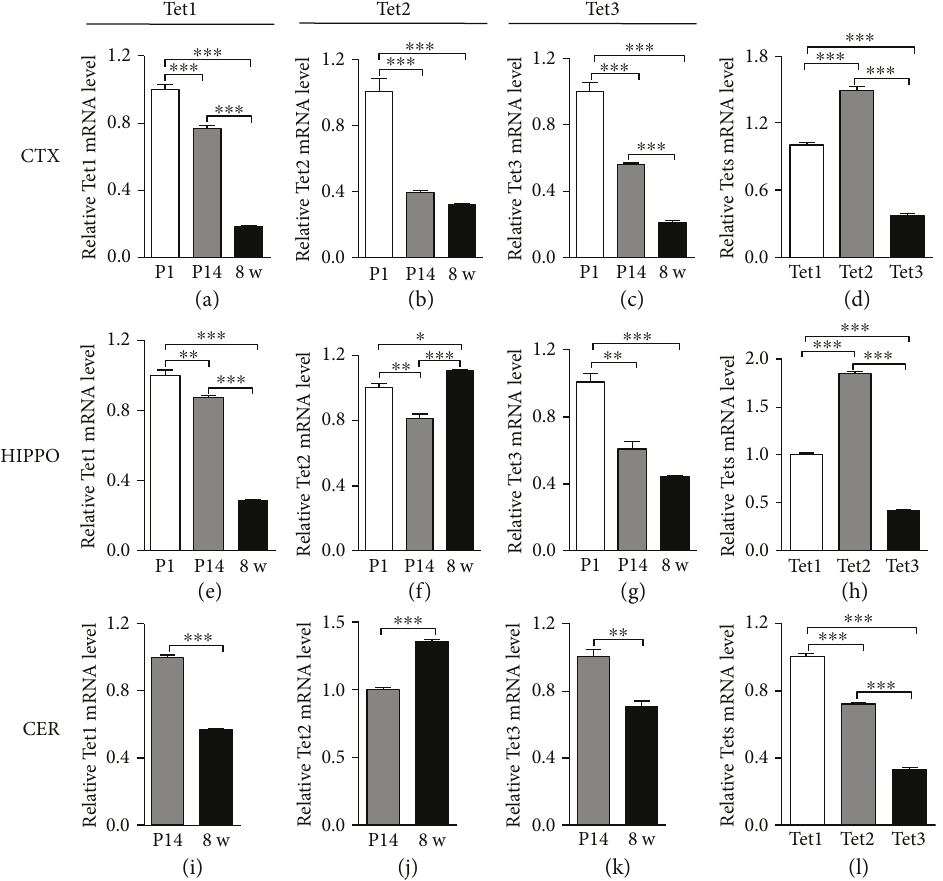
Figure 3: The mRNA levels of Tets in di ff erent brain regions. The relative mRNA levels of Tet1 , Tet2 , and Tet3 in the cortex from P1 to 8w ((a) – (c)). The relative mRNA levels of Tet1 , Tet2 , and Tet3 in the hippocampus from P1 to 8 w ((e) – (g)). The relative mRNA levels of Tet1 , Tet2 , and Tet3 in the cerebellum from P1 to 8 w ((i) – (k)). Comparison of Tet1 , Tet2 , and Tet3 mRNA levels in di ff erent brain regions at 8w ((d), (h), (l)). Data are represented as mean ± SEM ( n = 3 ). Statistically signi fi cant di ff erences are indicated: ∗ p < 0 05 , ∗∗ p < 0 01 , and ∗∗∗ p < 0 001